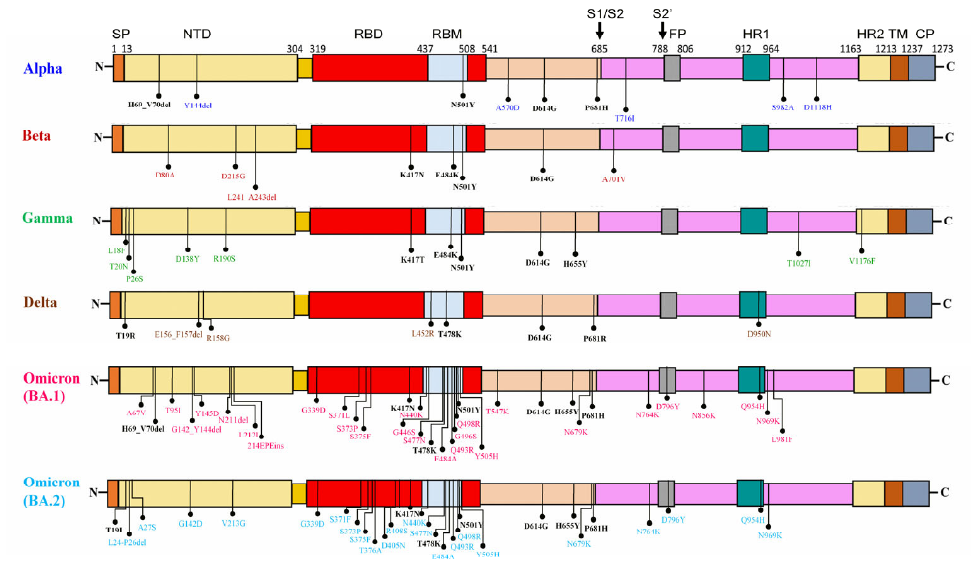
Figure 2. Mutational profiles of the Variants of Concern’s spike protein. Mutations that differed from those of other VOCs are denoted by different VOC-specific colours, while the shared mutations are represented by the black colour. SP, Signal Peptide; NTD, N-terminal domain; RBD, Receptor-Binding Domain; RBM, Receptor-Binding Motif; SD1, subdomain 1; SD2, subdomain 2; FP, Fusion peptide; HR1, Heptad repeat region 1; HR2, Heptad repeat region 2; TM, Transmembrane domain; CP, Cytoplasmic domain.